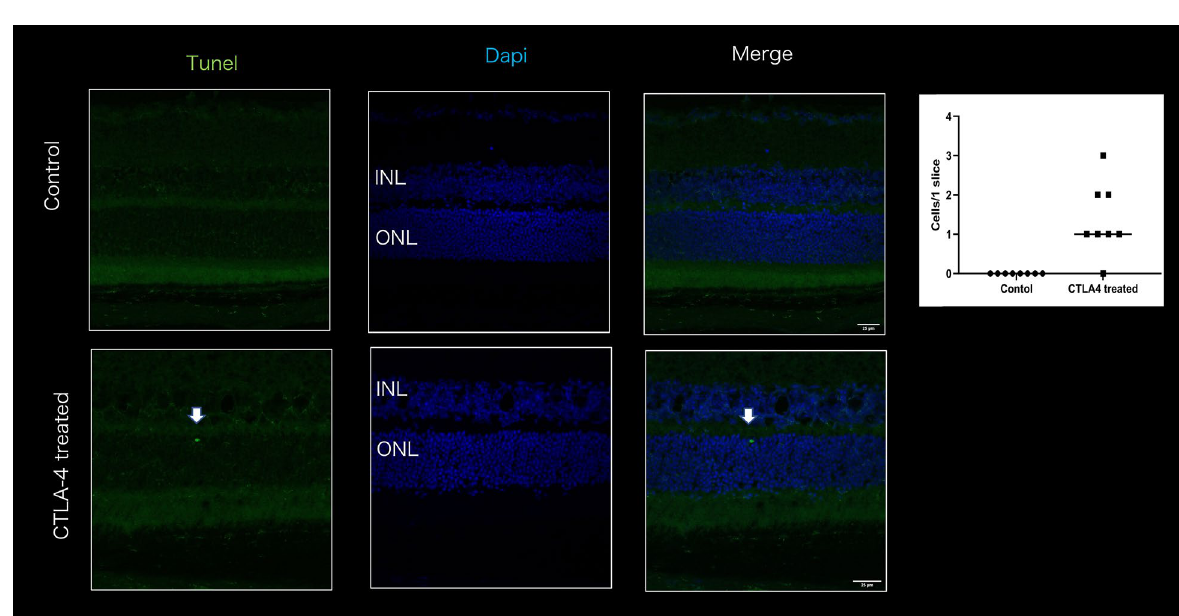
Figure 4. Peanut agglutinin (PNA) staining in control and anti-CTLA4-treated eyes (n = 4 in each group). Control eyes exhibited linear staining along the outer segment. In contrast, partial or fragmented staining was observed in treated eyes. The intensity of PNA staining was significantly lower in treated eyes than in control eyes. Scale bar: 50 μm. ** P > 0.01. RPE: retinal pigment epithelium, ONL: Outer nuclear layer, INL: Inner nuclear layer.